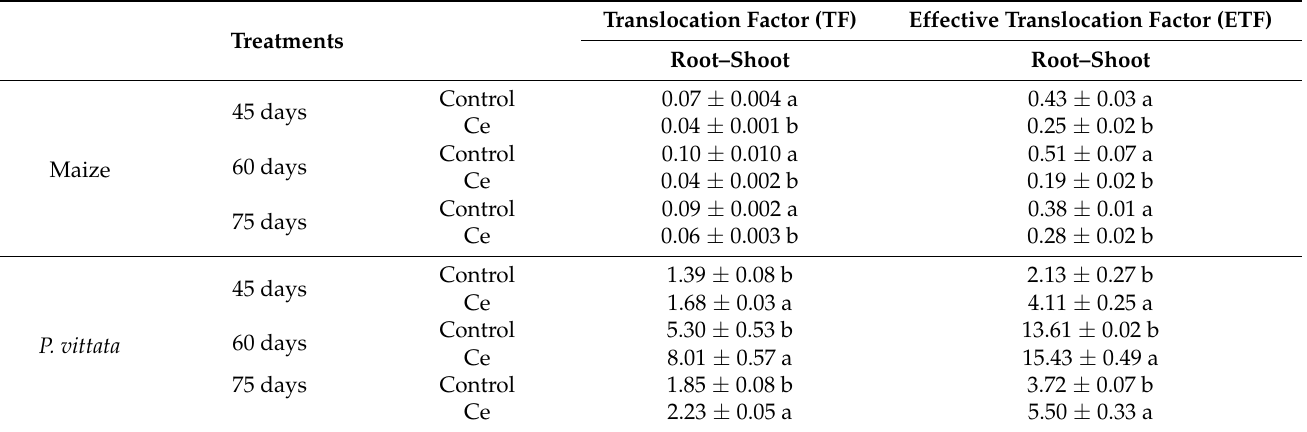
Table 4. Effects of Ce colonization on the characteristics of arsenic accumulation in maize and P. vittata under arsenic stress in different